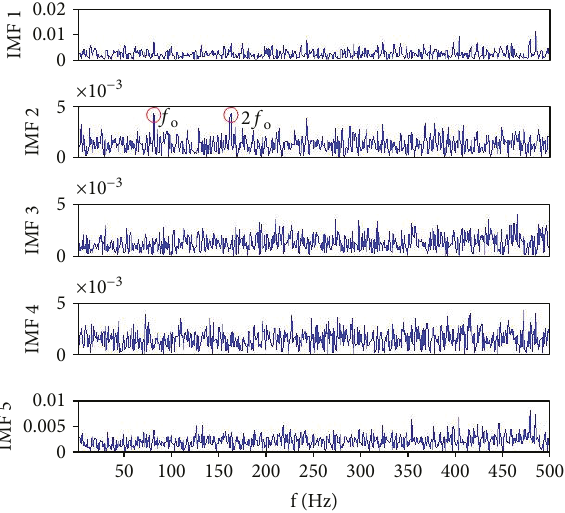
Figure 11: The result provided by CEEMDAN for experimental signal analysis.